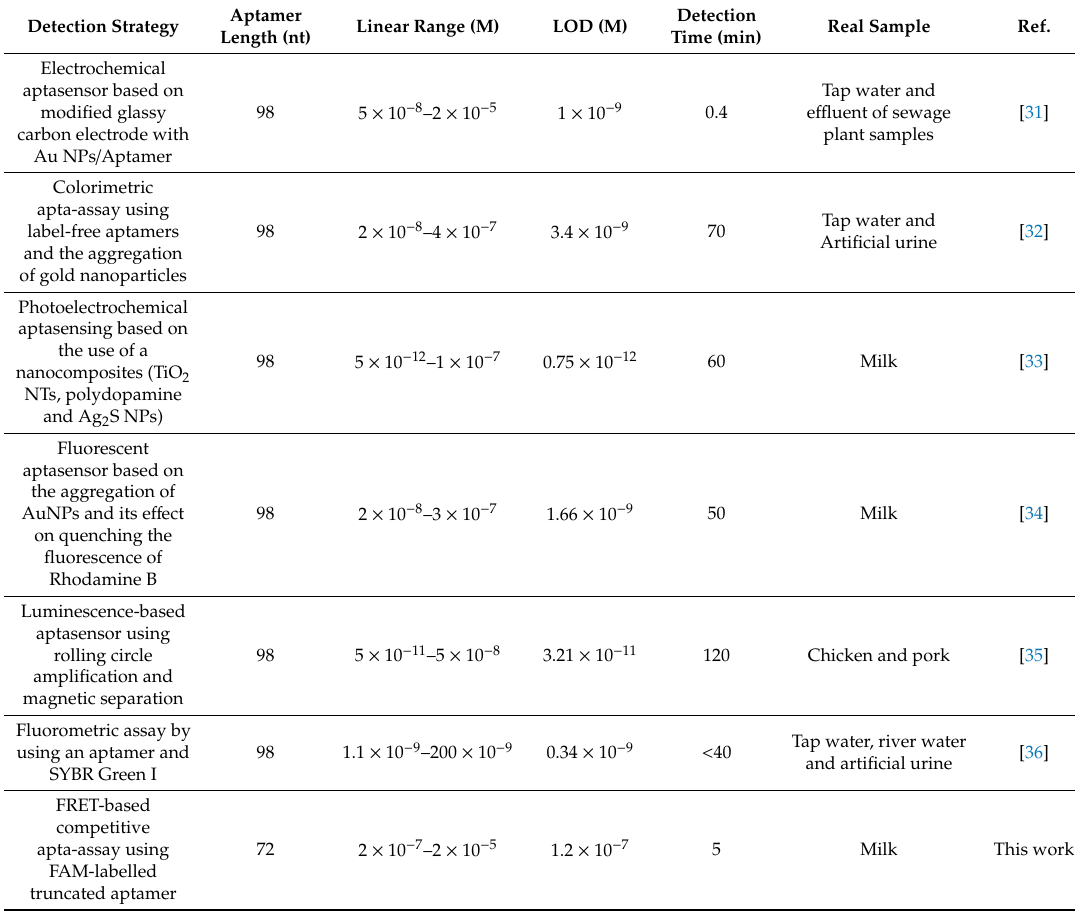
Table 2. Comparison with earlier optical aptasensing platforms for OFL